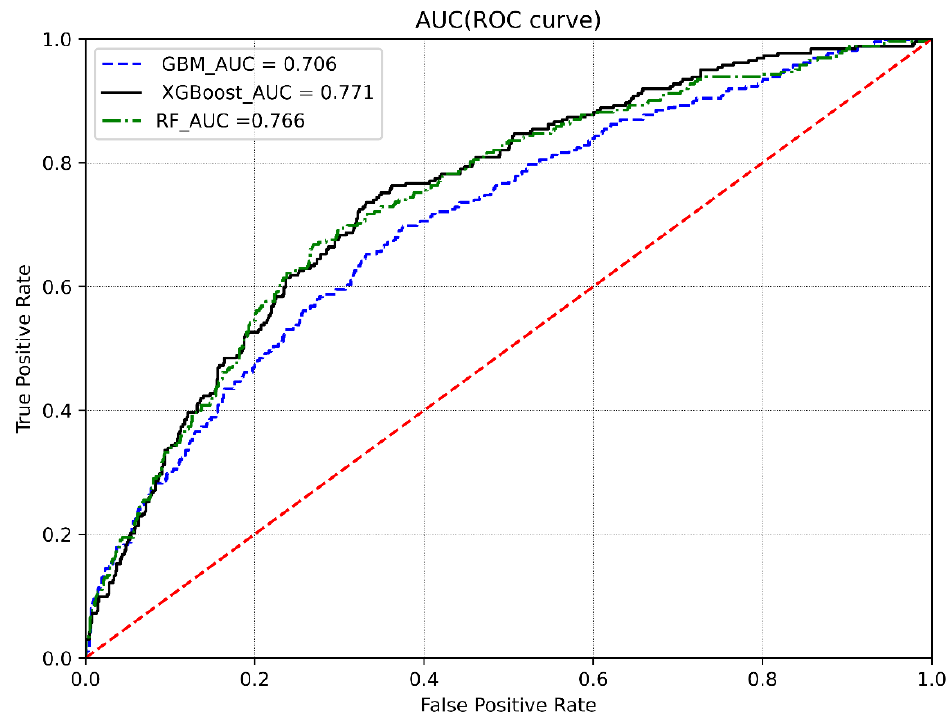
Figure 1. ROC curve for GDM prediction using three prediction models. XGBoost shows best per- formance.